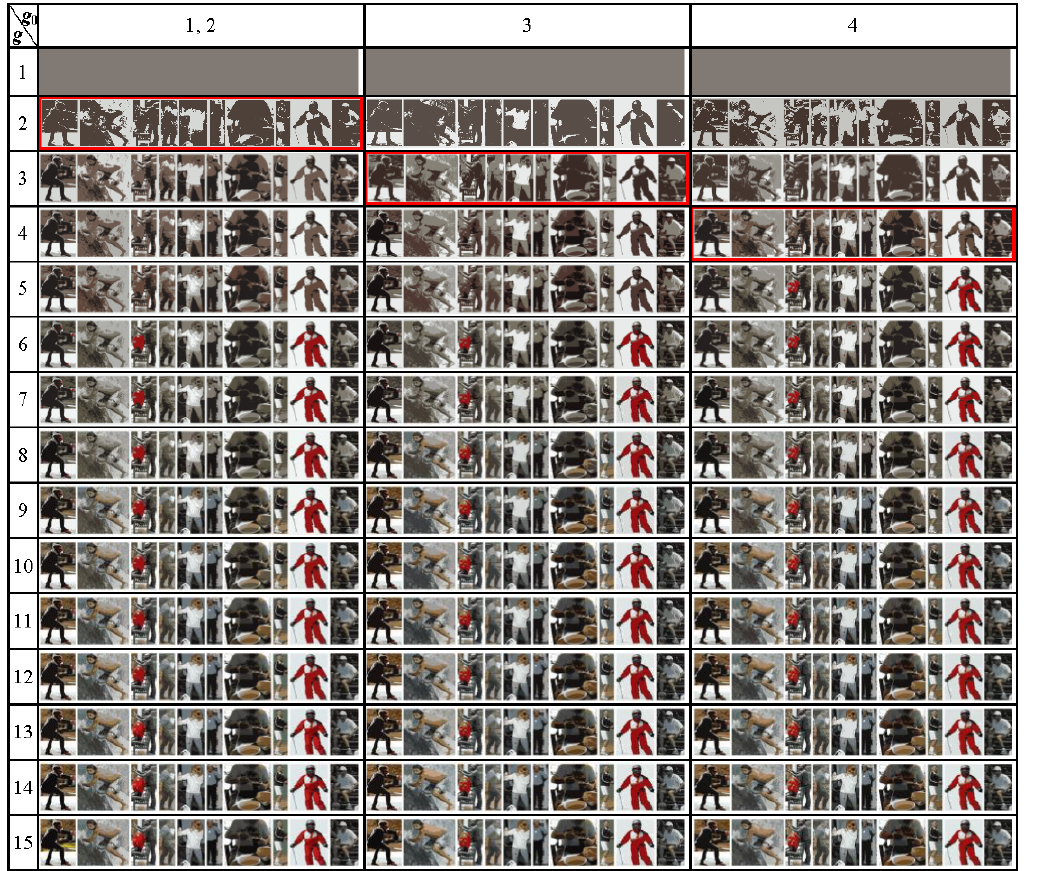
Figure 13. Dynamic Table of N × N image approximations, ordered along the columns and the main diagonal. Diagonal elements are highlighted in red. Dynamic Table demonstrates the hierarchies of image approximations arranged in columns.